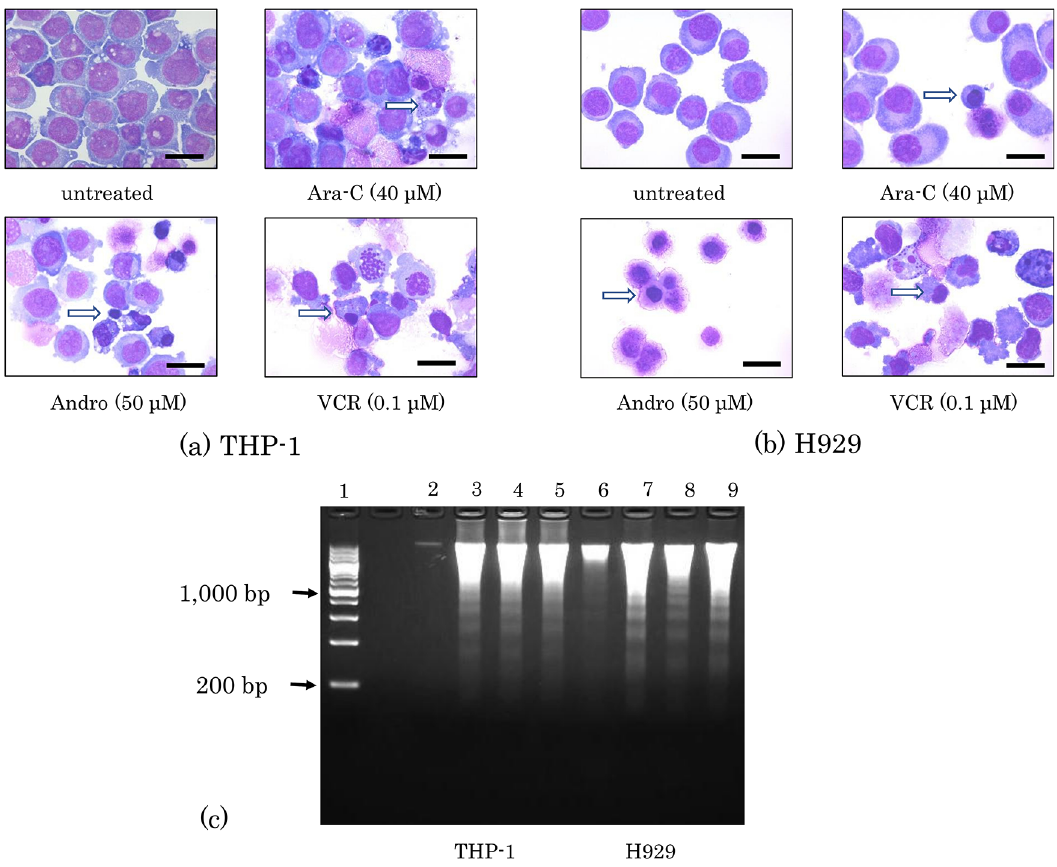
Figure 2. Morphological changes and DNA fragmentation induced by Andro, Ara-C, and VCR. Morphologies of THP-1 (a) and H929 (b) cells after 24 h of treatment with Andro, Ara-C, or VCR were compared with untreated cells after Wright-Giemsa staining. White arrows indicate cells showing nuclear condensation and black scale bars represent 20 μ m. (c) Nuclear DNA fragmentation was revealed by agarose gel electrophoresis of DNA isolated after 24 h of treatment with Andro (50 μ M), Ara-C (40 μ M), or VCR (0.1 μ M) in THP-1 (lanes 2-5) and H929 cells (lanes 6-9). Lane 1, DNA size marker; lanes 2 and 6, untreated cells; lanes 3 and 7, cells treated with Andro; lanes 4 and 8, cells treated with Ara-C; lanes 5 and 9, cells treated with